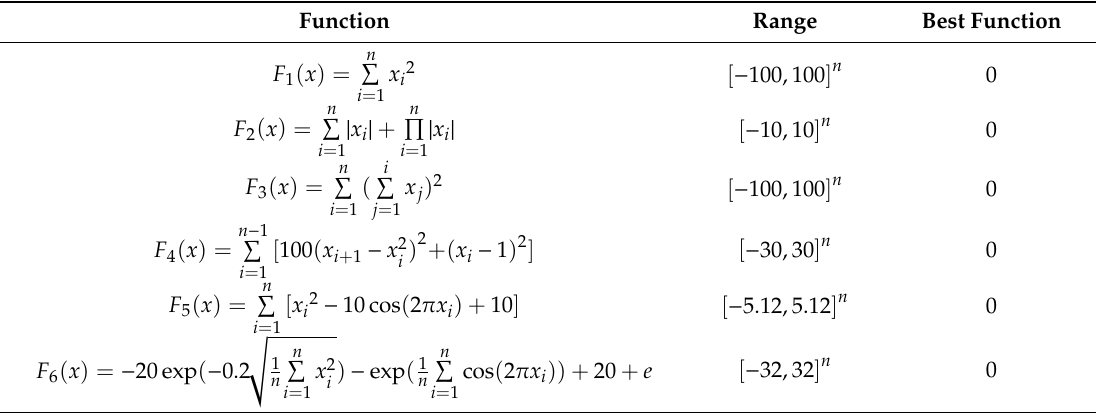
Table 2. Details of the benchmark